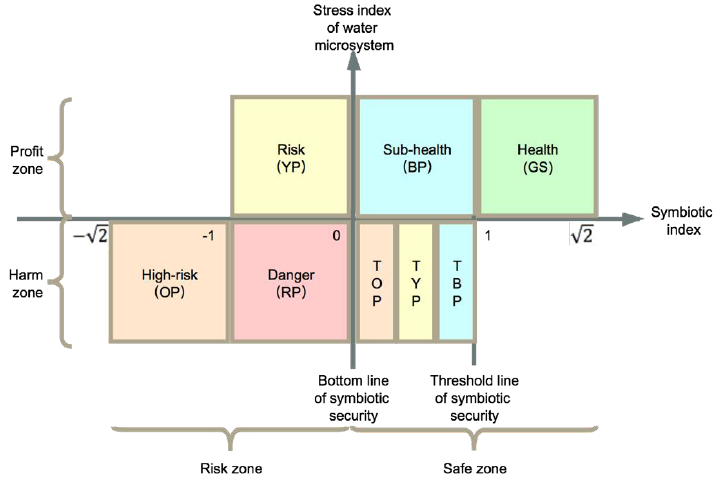
Figure 5. Dual feature judgment matrix of water security level. Note: GS = green security, BP = blue pre-warning, YP = yellow pre-warning, OP = orange pre-warning, RP = red pre-warning, TOP = transition orange pre-warning, TYP = transition yellow pre-warning, TBP = transition blue pre-warning. Table 2. The judgment criteria of water security state and pre-warning level from the perspective of water-energy symbi- osis and water-food symbiosis. S WE/WF ( k )